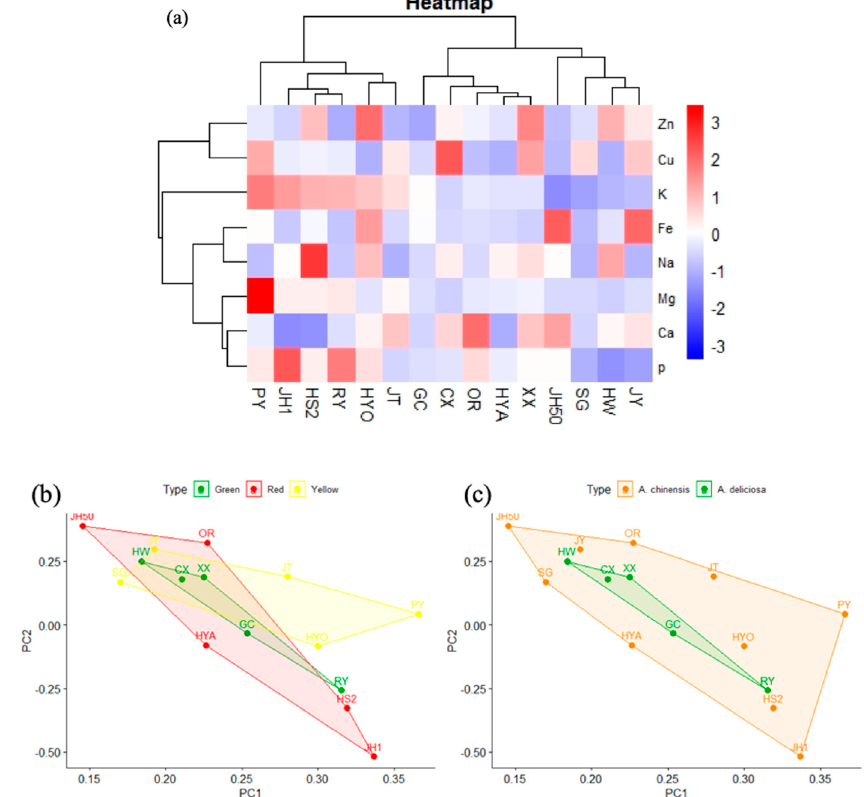
Figure 8. Preliminary analysis of trace element data. ( a ) Cluster heat map of trace elements in 15 kiwifruit cultivars. ( b ) PCA score plot of trace elements in different flesh colors. ( c ) PCA score plot of trace elements in two species.